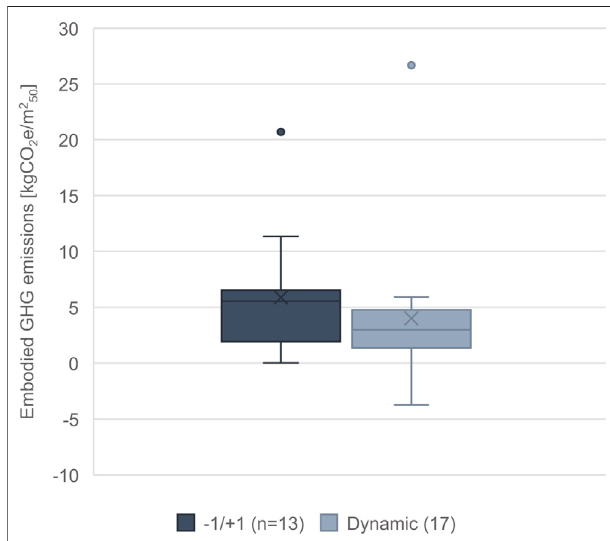
FIGURE 7 | Embodied GHG emissions distributed on approach to biogenic carbon counting and system boundaries. The dots in the plot indicate the outliers of the dataset. The boxes and the line within the boxes indicatethequartilesofthedataset(25percentile,50percentile (median) and 75 percentile). The x indicates the average. The error bars outside the boxes indicate the deviation in the data.